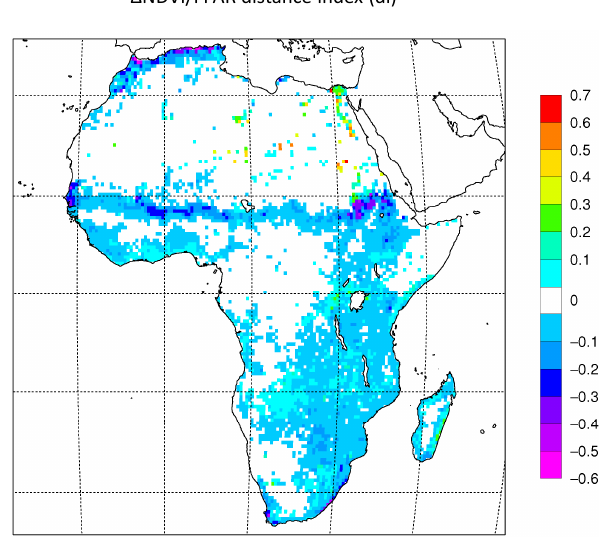
Fig. 6. Difference in distance index (di) for monthly observed NDVI and modelled FPAR between a simulation with specific representa- tions of cropland and pasture (S1.7) and a simulation with natural vegetation only (S0) for the period 1982–2006. Cropland is simu- lated without cover crop grass and with the default sowing method (temperature-dependent) for irrigated crops. Negative values are im- provements to the FPAR vs. NDVI fit of standardised seasonal vari- ation. Grid cells where the year 1992 cropland fraction is below 2% are masked out.